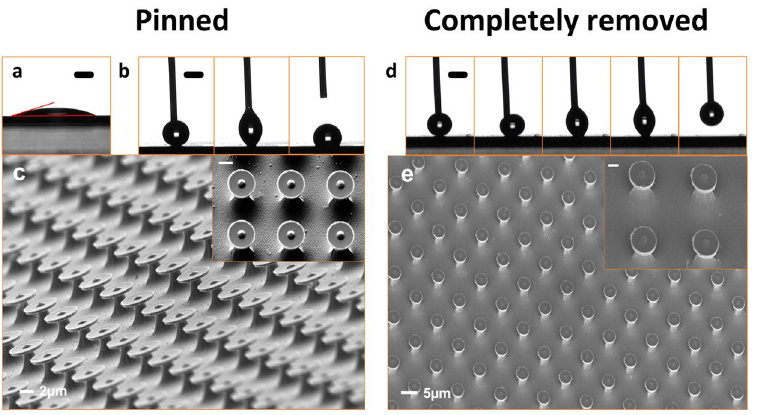
Figure 3. Designing surface morphologies to make water repellent surfaces. ( a ) Water droplet on a flat InP wafer, which is readily wetted (contact angle = 22.4°), indicating its hydrophilicity (scale bar = 1 mm). ( b ) Sample A1: Water droplet contacts a textured InP surface with re-entrant structures (D = 4.5 μ m, L = 8 μ m, H = 2.5 μ m, λ 1 = 0.249, where λ is the fraction of the solid in contact with the liquid); the water droplet was eventually pinned on the surface (contact angle = 124.5°). ( c ) SEM images of the designed surface used in b; insert shows a top view of the pillars (scale bar = 2 µ m). ( d ) Sample A2: Water droplet contacts a designed InP surface with re-entrant structures (D = 4 μ m, L = 10 μ m, H = 2 μ m, λ 2 = 0.126). A smaller contact fraction enables the water droplet to be removed completely from the surface (scale bar = 1 mm). ( e ) SEM images of the designed surface used in d. Insert shows a top view of the pillars (scale bar = 2 µ m). (Water droplet size in all cases: ~2 μ